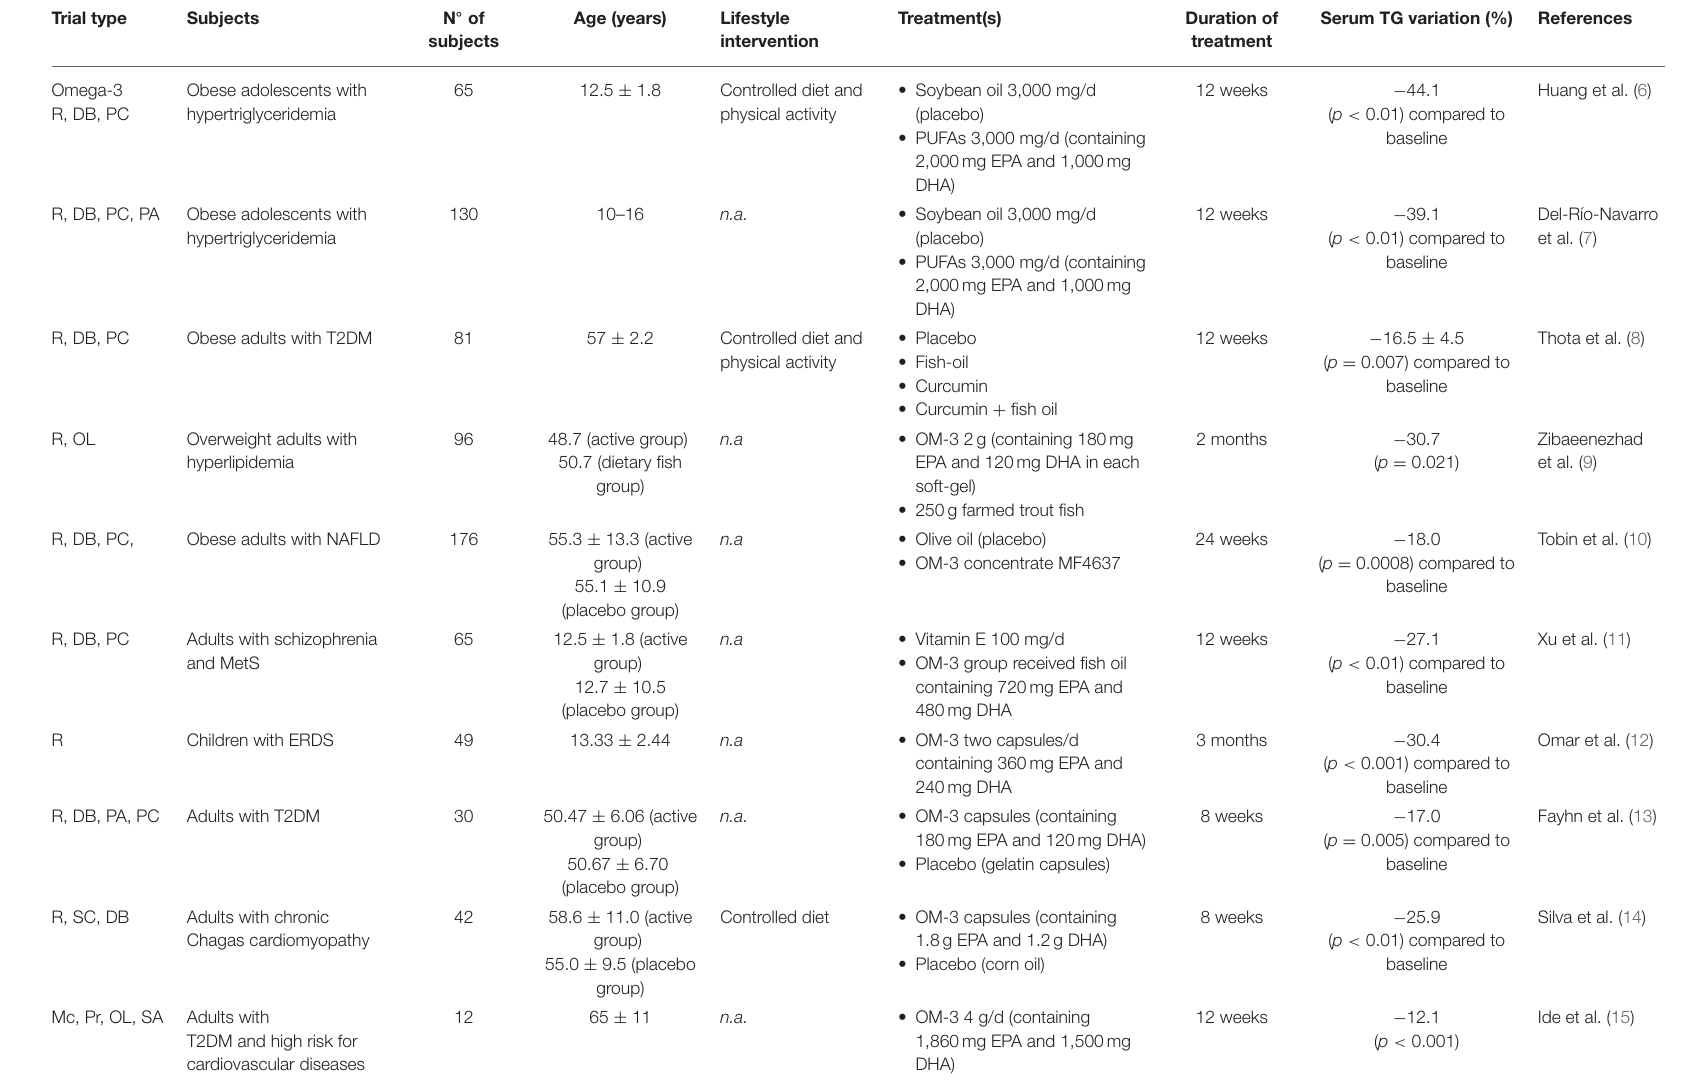
TABLE 1 | Most relevant published clinical trials from the last 5 years reporting TG-reducing effect after chronic supplementation with food-derived bioactive compounds. Trial